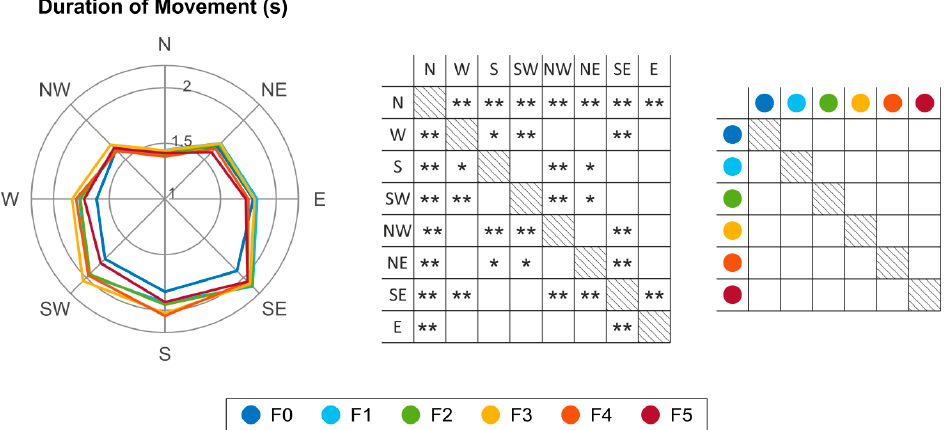
Figure 3. Duration of movement (T): mean values among subjects and repetition for each force and each direction on the left; on the right the two-way ANOVA results: statistical Differences between the direction and between the force. (‘*’ represents p -value < 0.05; ‘**’ represents for p -value < 0.01).